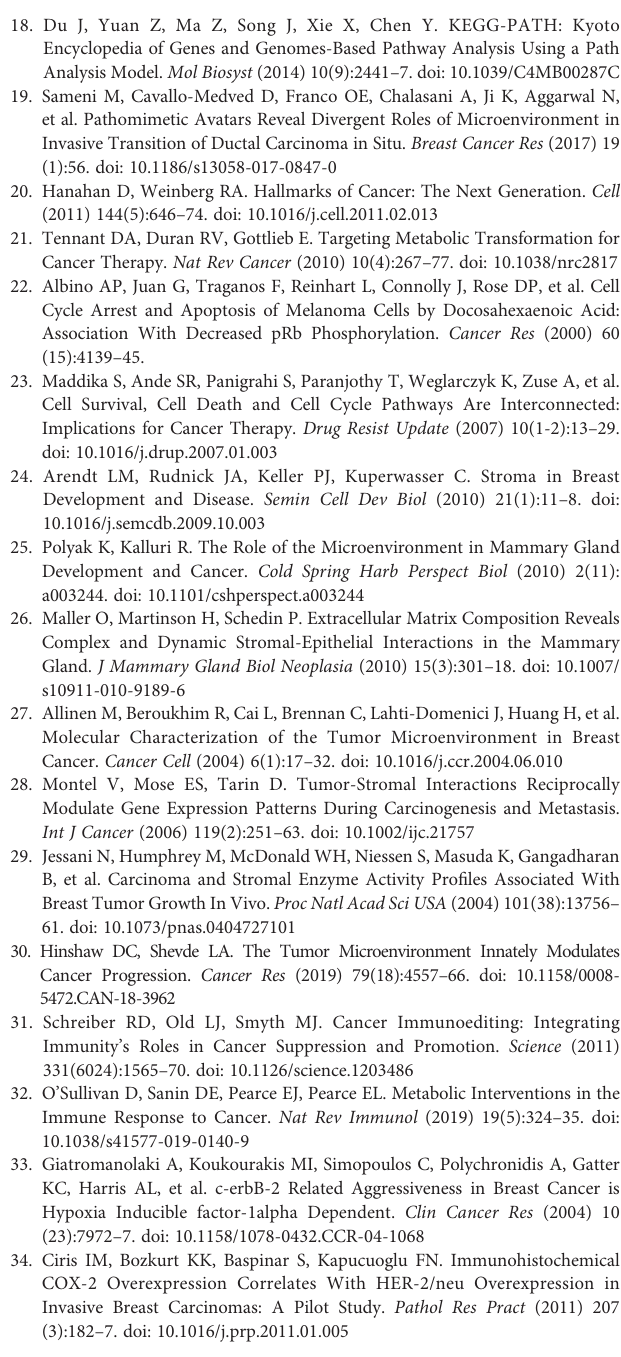
Supplementary Figure 1 | Scatterplots of gene signi fi cance for breast disease vs. module